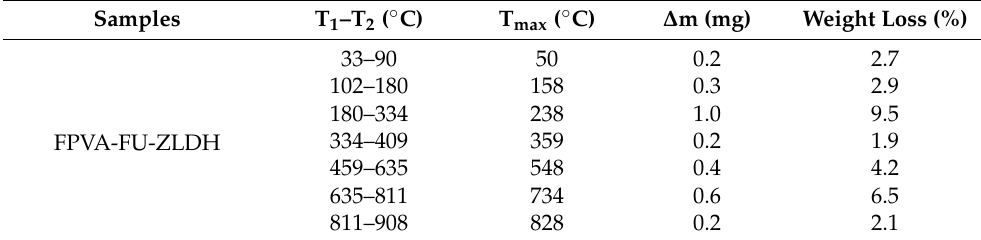
Figure 3. TGA/DTG thermograms for the bare PVA ( A ), ZLDH ( B ), 5-FU ( C ), and FPVAFU- ZLDH ( D ). Table 1. Thermal behavior of the